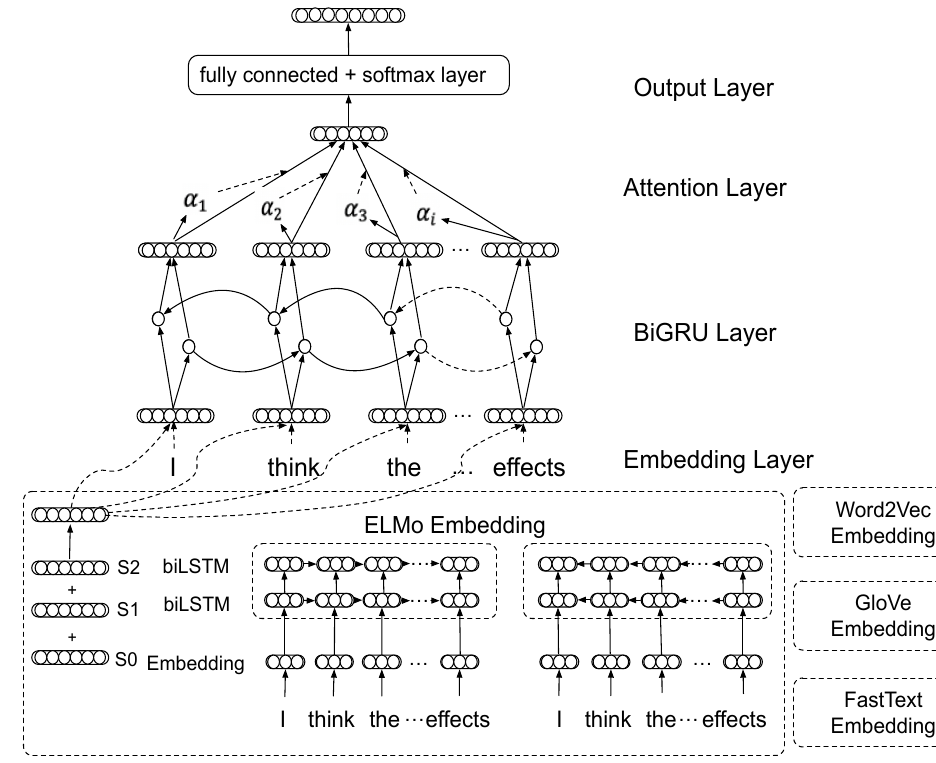
Figure 1. The architecture of diverse word embeddings processed by BiGRU-Att (DWE-BiGRU-Att).